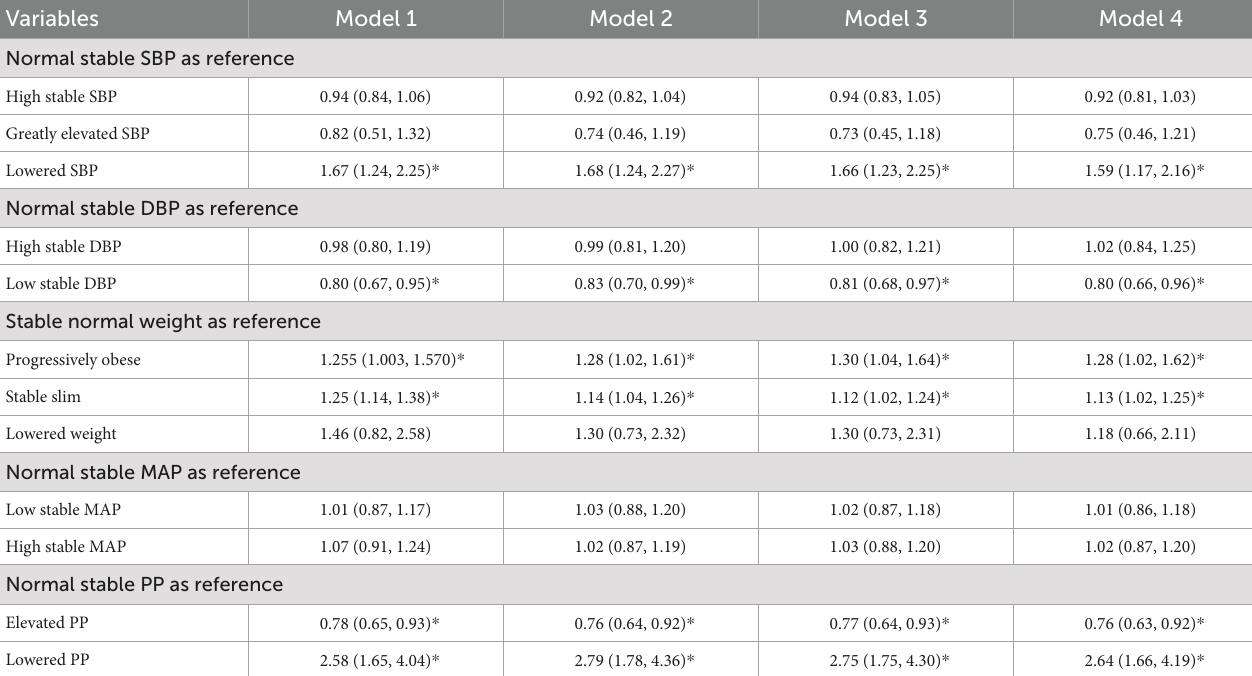
TABLE 3 Effects of CVRF trajectories on the risk of cognitive